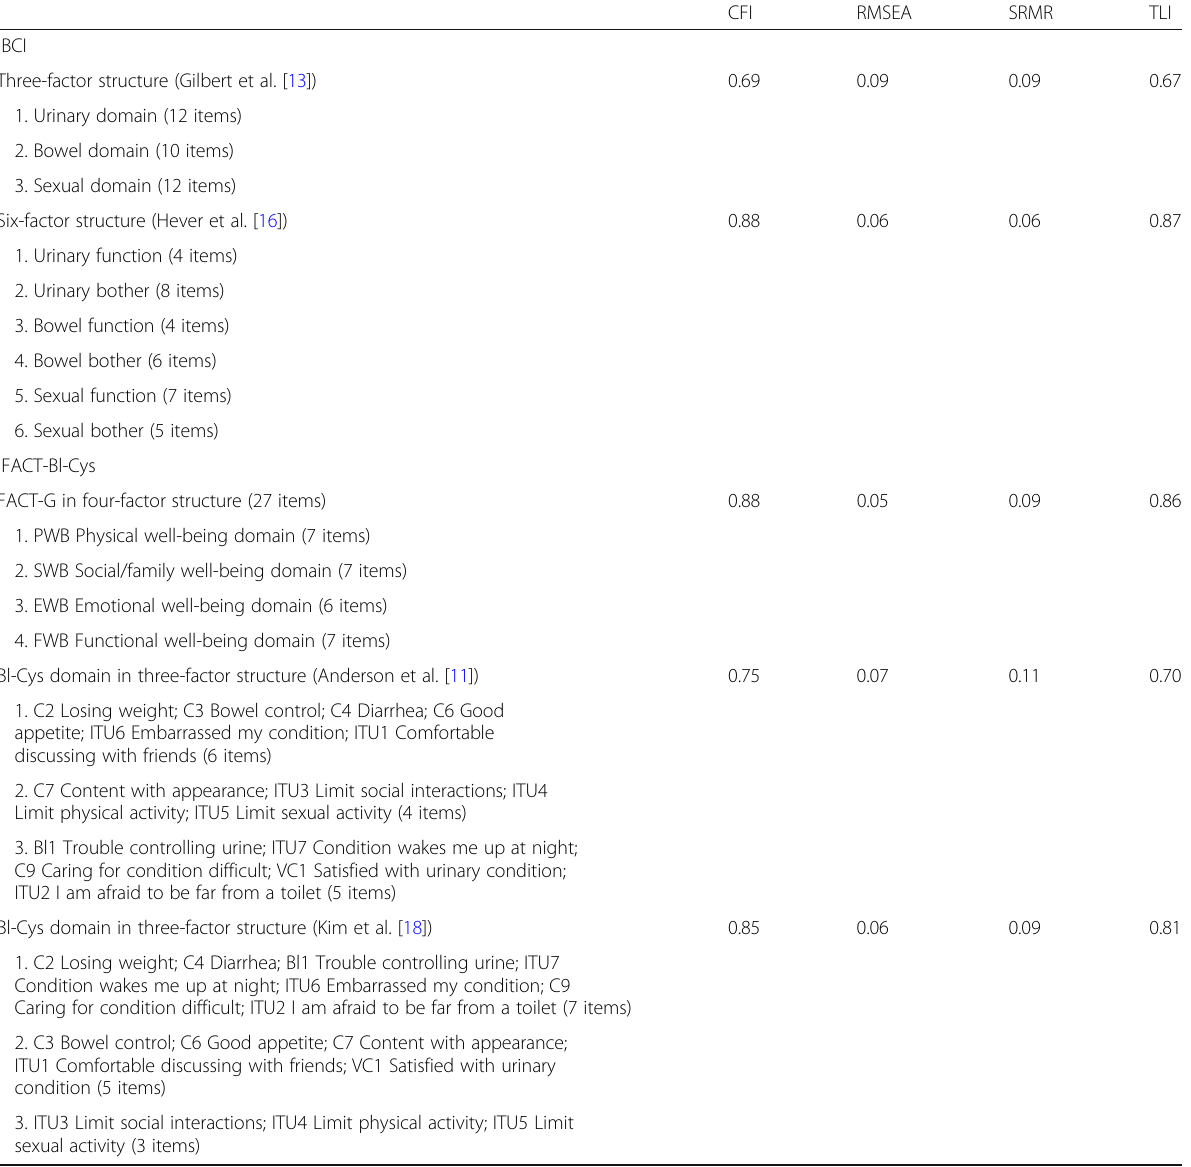
CFI RMSEA SRMR TLI